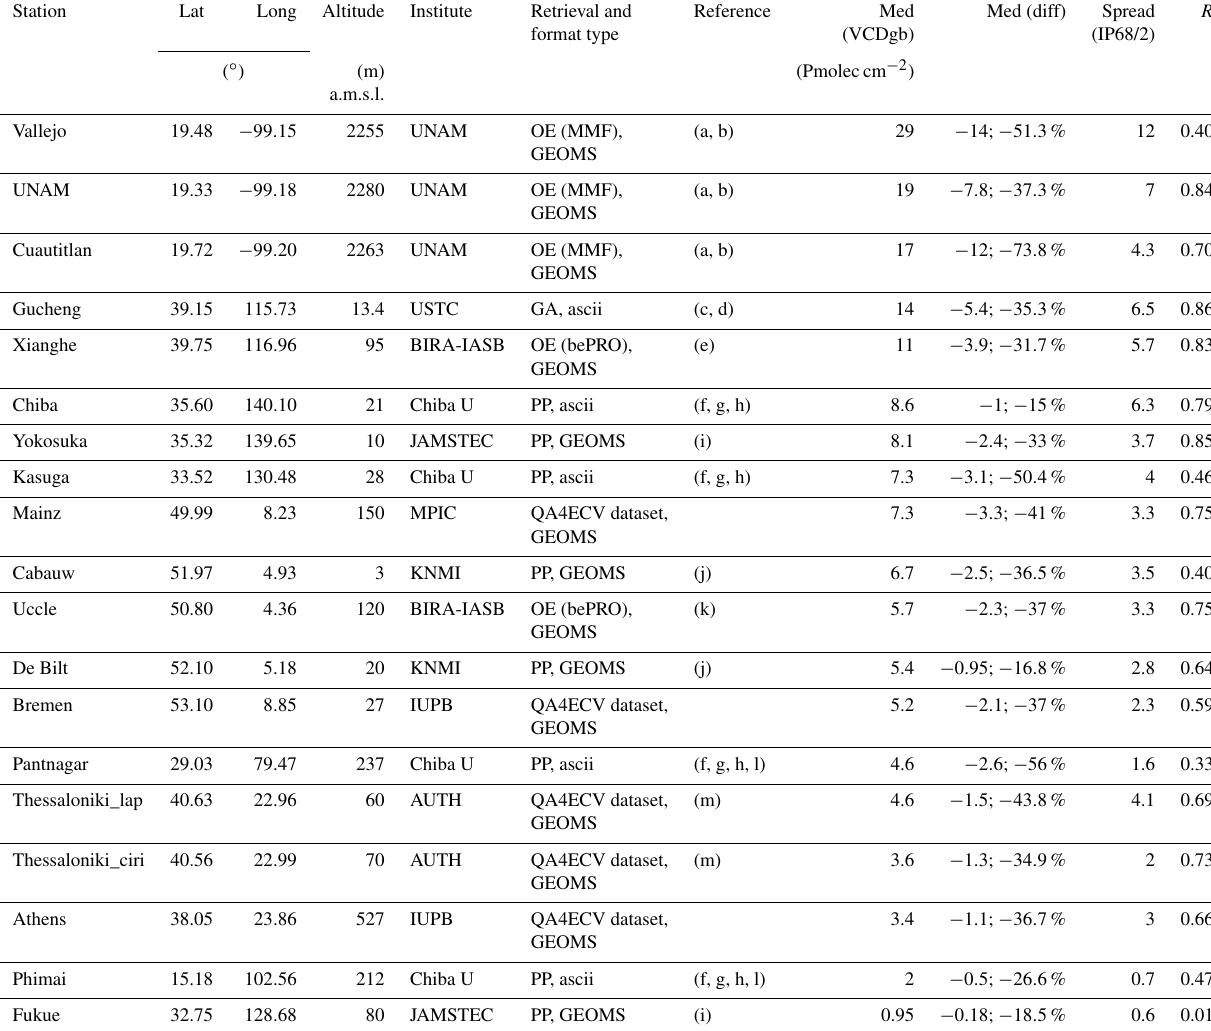
Table A2. MAX-DOAS hosting stations, ordered by increasing median tropospheric column (VCDgb, lowest at the bottom), that contribute to the tropospheric NO 2 column validation. More details on the QA4ECV datasets can be found at http://www.qa4ecv.eu/ecvs (last access: 5 January 2021). References are the following: (a) Arellano et al. (2016), (b) Friedrich et al. (2019), (c) Xing et al. (2017), (d) Xing et al. (2020), (e) Hendrick et al. (2014), (f) Irie et al. (2011), (g) Irie et al. (2012), (h) Irie et al. (2015), (i) Kanaya et al. (2014), (j) Vlemmix et al. (2010), (k) Gielen et al. (2014), (l) Hoque et al. (2018), (m) Drosoglou et al. (2017). Several measures of the agreement between TROPOMI and the ground-based data are also provided. Biases and comparison spreads vary strongly between stations, mainly as a function of the nature of the site (clean or polluted). When calculating these numbers for the three regimes (clean, polluted, extreme), the median biases are − 0 . 3, − 2, and − 12Pmoleccm − 2 ( − 23%, − 37%, and − 51%) respectively, with median dispersions of 0.7, 3.4, and 7Pmoleccm − 2 . Note that the median values for the high tropospheric columns (Athens to Xianghe) are almost the same as the statistics found for the whole network. The site–site bias dispersion is 0.2, 1.2, and 3.3Pmoleccm − 2 for each